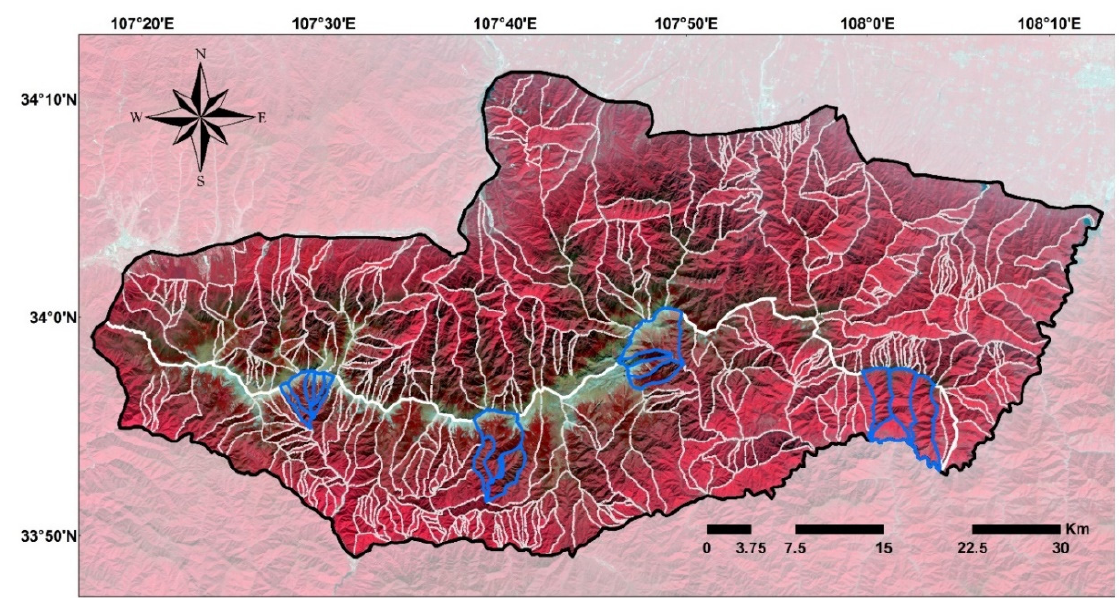
Figure 3. The GF-2 high-spatial-resolution remote sensing (HSR-RS) image (2016/7, 4/3/2 band combination) and geographic location of the study area (the polygons with bule boundary lines are four subareas for details in the following Figure 6).